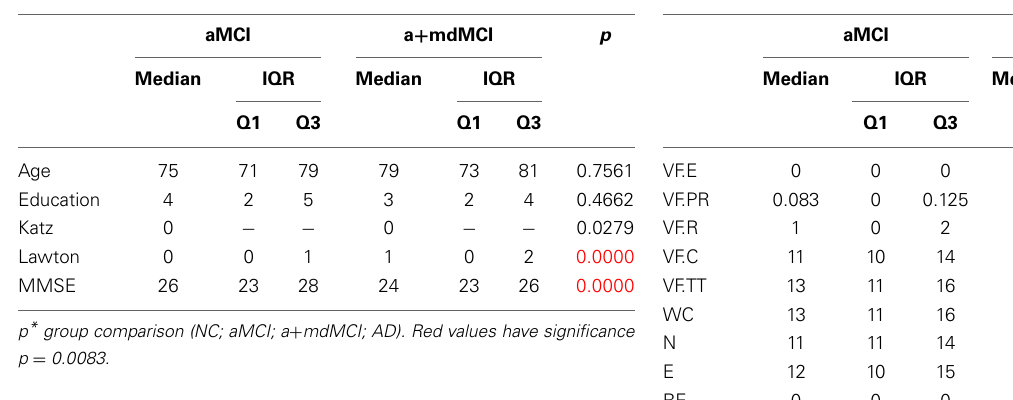
Table 7 | Additional description of verbal fluency and Speech Graph Attributes for the MCI subtypes, and the four groups